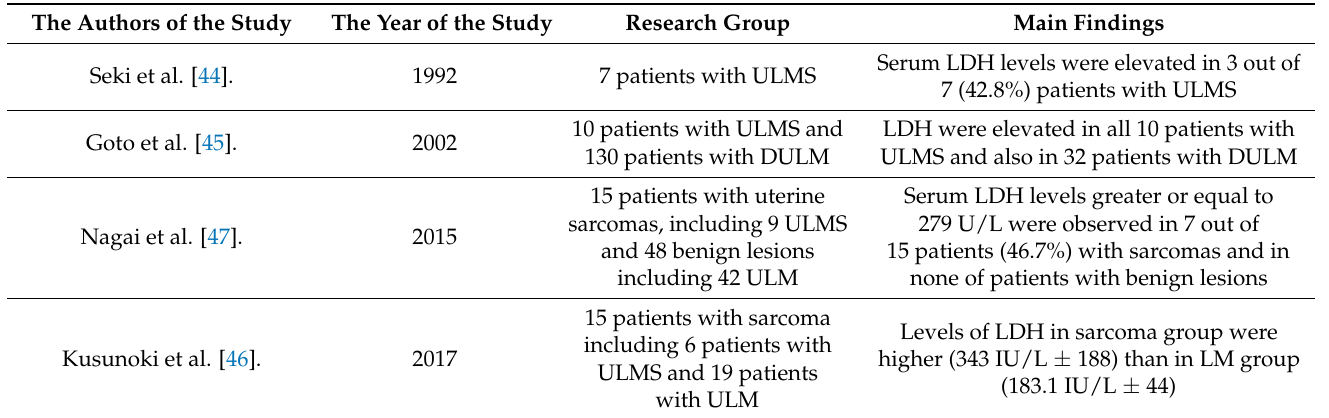
Table 2. The studies of LDH levels in ULMS and ULM